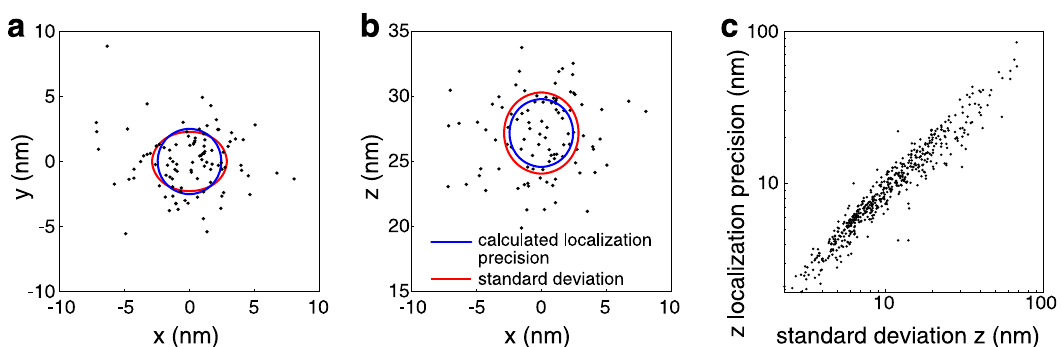
Fig. 2 Validation using fl uorescent beads. 50-nm red beads were immobilized on the coverslip and imaged 100 times to calculate the experimental localization precision as the standard deviation of the coordinates. a x – y scatter plot of the fi tted localizations of a single bead, b x – z scatter plot. z coordinates are based on dSALM alone. The red line denotes the experimental localization precision calculated as the standard deviation of the coordinates. The blue line denotes the average calculated localization precision based on the Cramér-Rao-Lower Bound (Eq. 7, Methods). c A comparison of calculated and experimental localization precision in z for 525 beads in two independent experiments, measured with different excitation laser powers spanning two orders of magnitude, leading to a brightness of the beads between 150 and 15,000 photons. Source Data are available as a Source Data fi le for Fig.